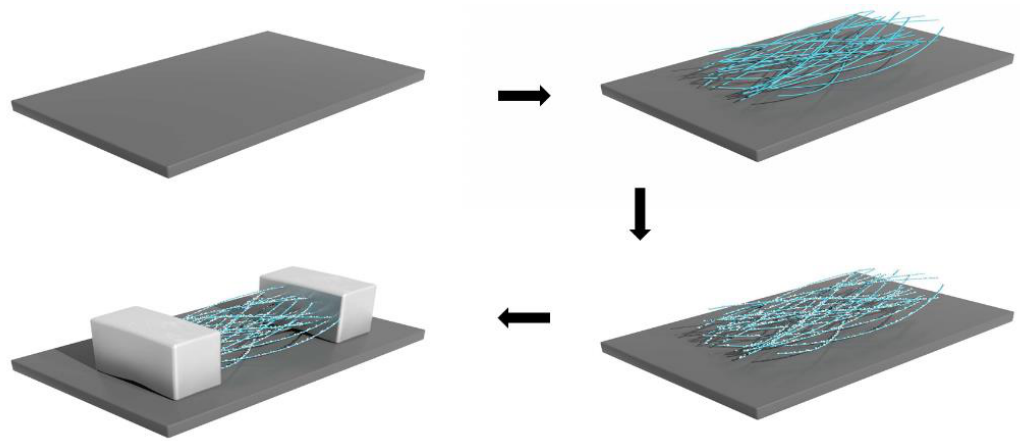
Figure 1. Schematic diagram of the hydrogen sensors.